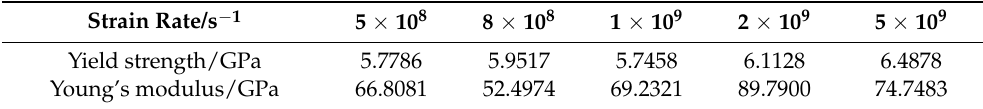
Table 1. Young’s modulus and yield strength of SC-HEA at different strain